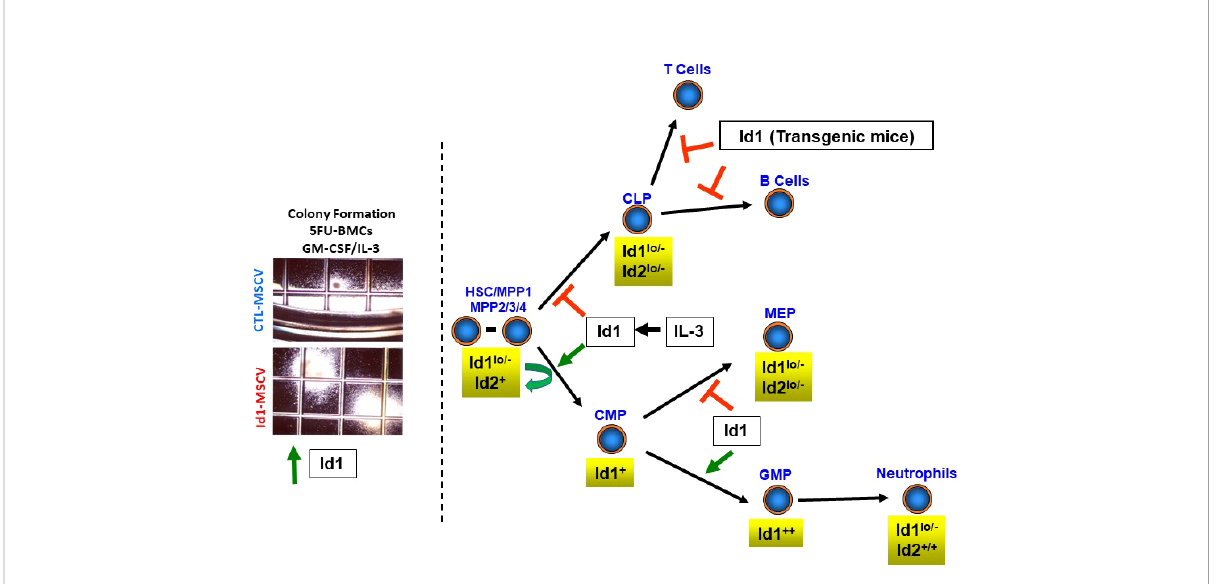
FIGURE 1 Summary of Id gene expression in hematopoietic stem and progenitor cells. Levels of Id gene expression are shown for hematopoietic stem cells (HSCs), multipotent progenitor (MPP) cells, clonogenic lymphoid progenitors (CLPs), common myeloid progenitors (CMPs), granulocyte/ macrophage progenitors (GMPs) and megakaryocyte/erythroid progenitor cells. Photomicrographs of BMCs harvested from mice three days after the administration of 5-FU, transduced with control and Id1 expressing retroviral vectors and cultured in methycellulose for 7-10 days (colony formation